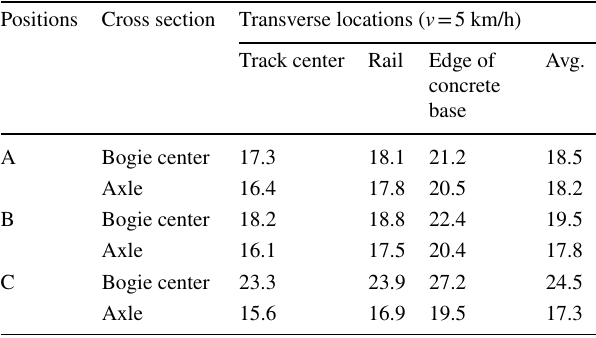
Table 3 Stress level on roadbed with different loading positions and sections by FEM (unit: kPa)